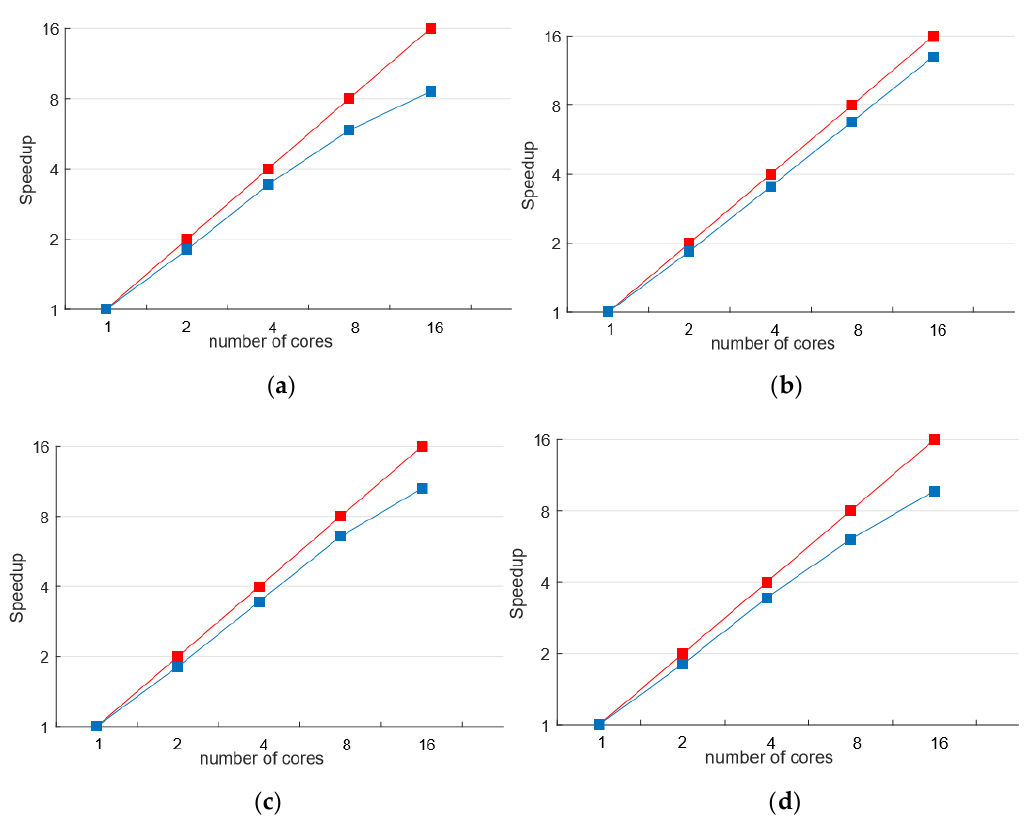
Figure 15. Speedup achieved by the proposed method (in blue squares) with increasing number of cores for ( a ) Sentinel-1 TOPS-mode image processing step; ( b ) Sentinel-1 interferometry step; ( c ) time series analysis step; and ( d ) the overall processing chain. The ideal achievable speedup is shown in red squares.